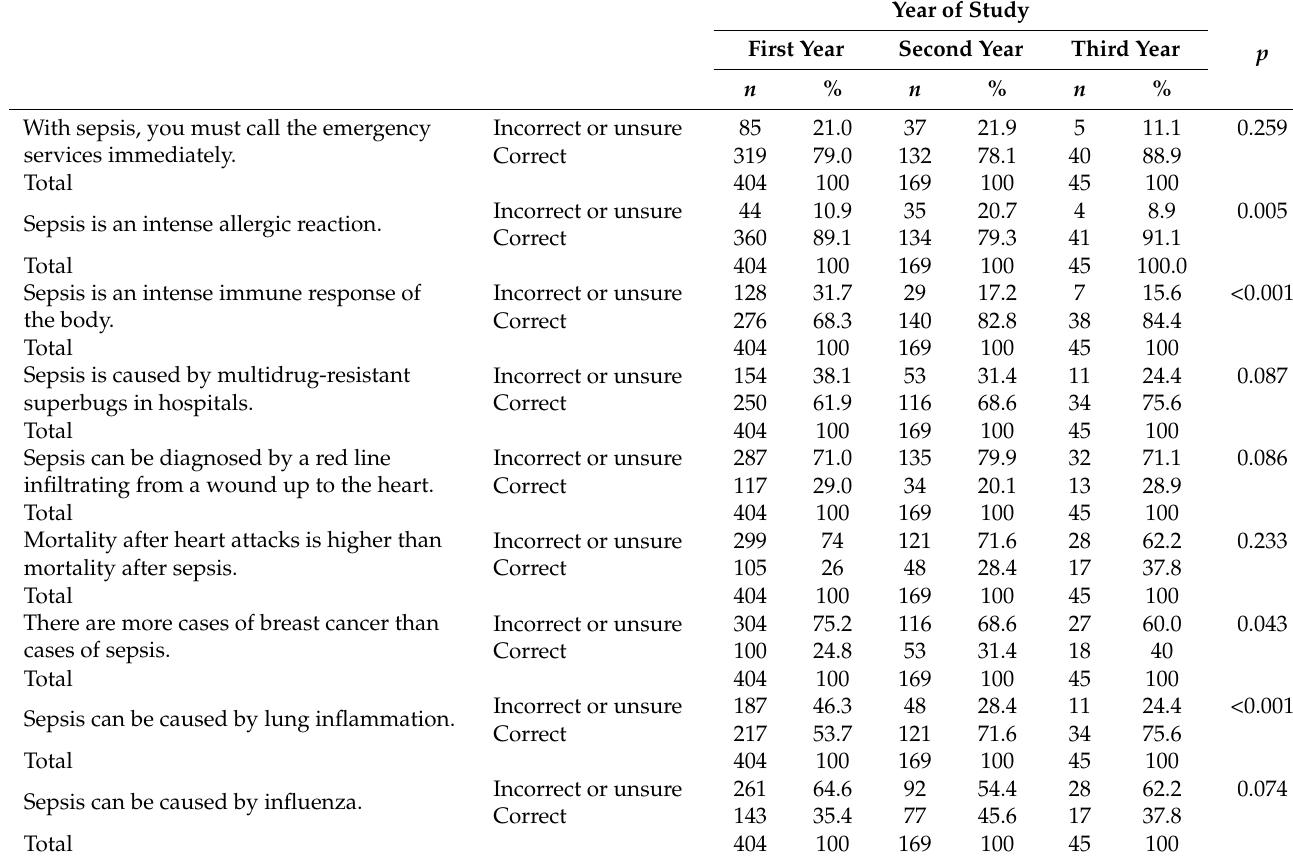
Table 2. Percentage and number of students with correct answers to “Knowledge of sepsis” according to the year of